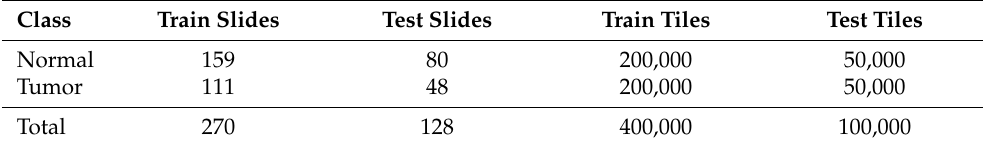
Table 2. Details of the CAMELYON16 dataset [16,17].